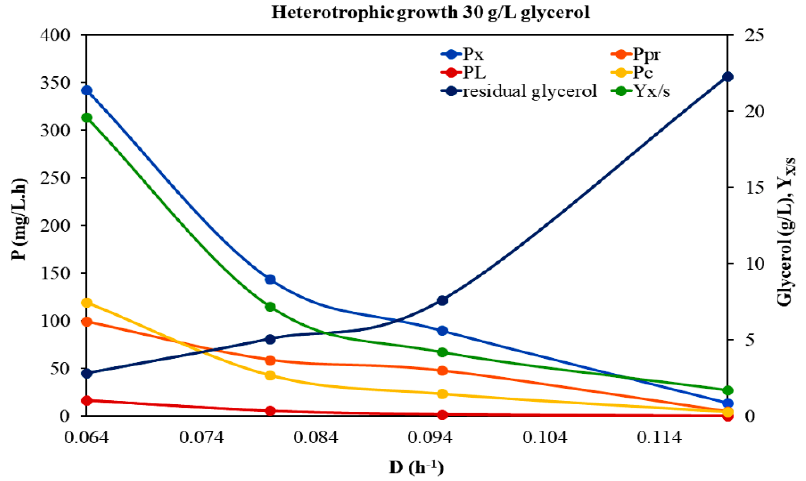
Figure 1. Effect of dilution rate ( D ) on the growth of Auxenochlorella protothecoides under heterotrophic conditions in BBM modified medium with initial glycerol concentration of 30 g/L. The variation in biomass productivity ( P x , mg/L · h), lipids productivity ( P L , mg/L · h), proteins productivity ( P Pr , mg/L · h), carbohydrates productivity ( P c , mg/L · h) residual glycerol and yield coefficient on glycerol ( Y x/S ), with the dilution rate, are displayed. The Y x/S has been increased a hundredfold (100 g/g). Within the dilution rates applied, the residual glycerol concentration increased with the increasing dilution rate. Applying Monod’s kinetic model and plotting the 1/ D vs. 1/ S curve, the µ max and K S values were determined as 0.134 h − 1 and 3.14 g/L, respectively. The µ max determined agreed with the fact that the cells were washed out when D increased from 0.120 to 1.155 h − 1 . The maximum biomass production of the system ( P max ) was estimated equal to 0.393 g/L · h at D = 0087 h − 1